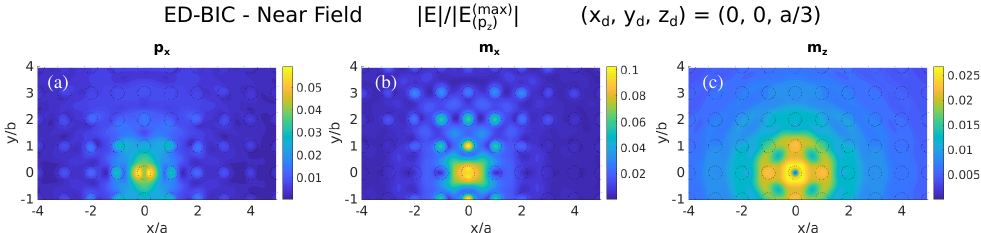
Figure 5. Color maps of total electric near-fields as in Figure 4a at the wavelength of the symmetry- protected ED-BIC ( λ = 532 nm), but illuminating with various point-dipole sources located also at ( x d , y d , z d ) = ( 0,0, a /3 ) : ( a ) in-plane electric ( p x ); ( b ) in-plane magnetic ( m x ); and ( c ) vertical magnetic ( m z ). In all cases, the electric field is normalized for the sake of comparison to the maximum of the field when excited by a vertical electric dipole p z .